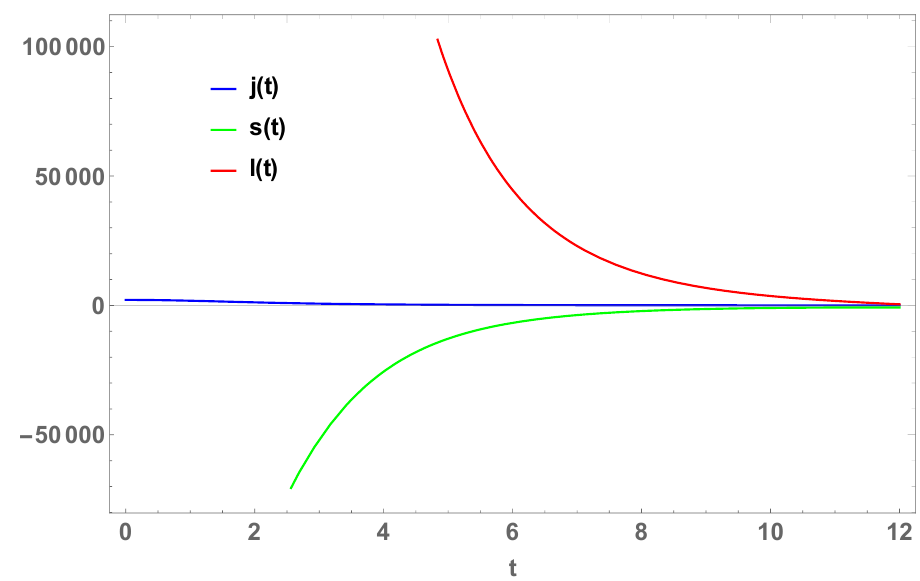
Figure 8. Behaviour of the jerk, lerk, and snap parameters ( l ) with respect to cosmic time t for different values of β with γ = 1.65, k =